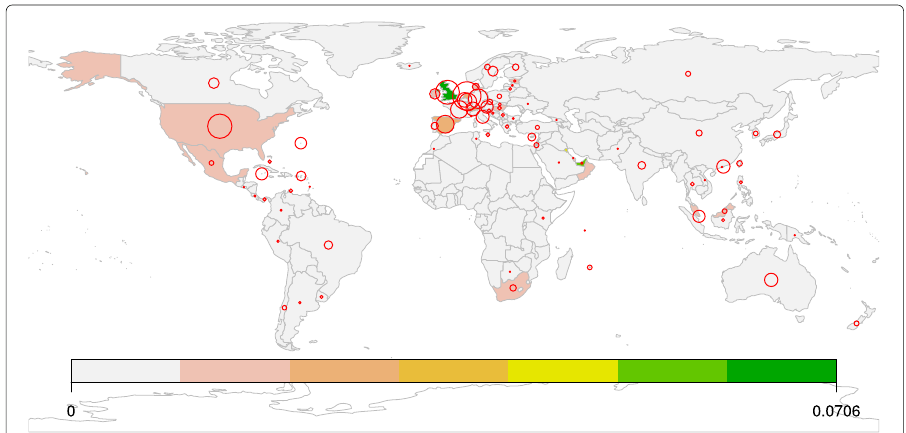
Fig. 11 “Holding” companies and Treaty shopping. The size of the circles indicates the number of “holding” companies and the depth of the color indicates the possibility to be used for treaty shopping by the jurisdiction